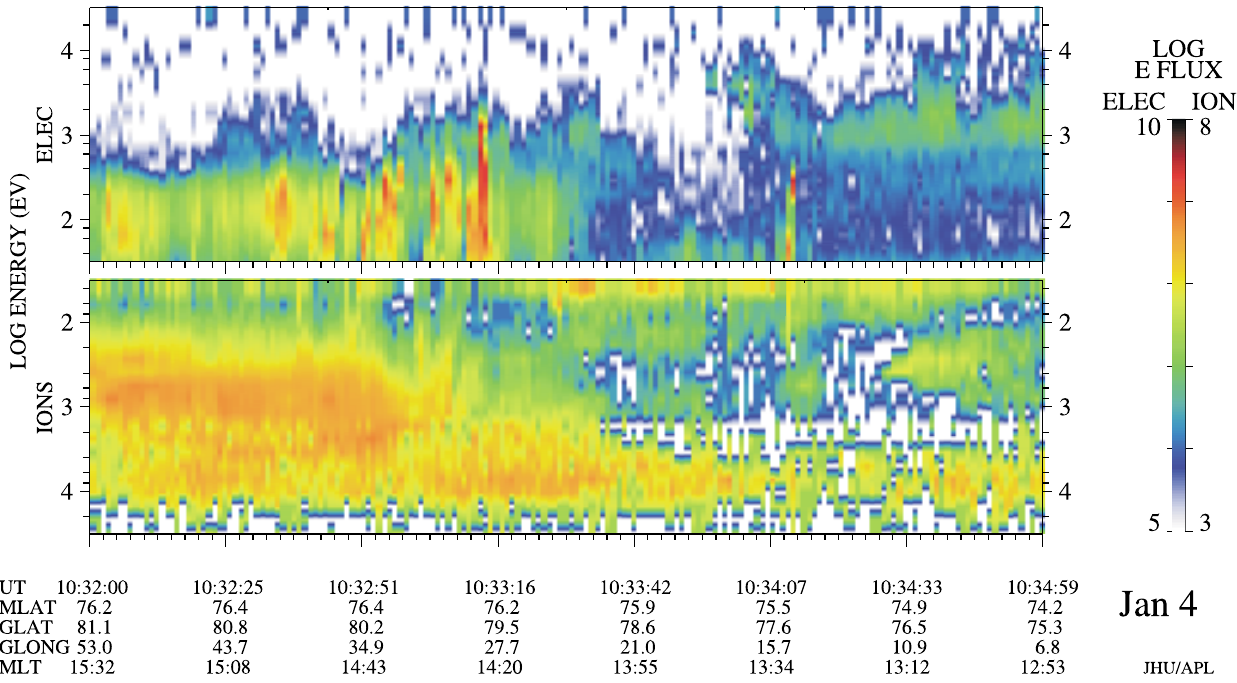
Fig. 6. DMSP spectrogram for the spacecraft overpass in Fig 5. Ion and electron fluxes are presented. Note the inverted energy scale in the ion